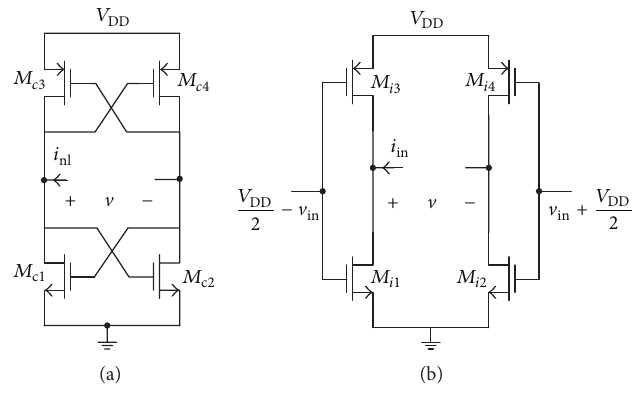
Figure 6: (a) Active part of the ILFD in Figure 5; (b) injection circuit of the ILFD in Figure 5.